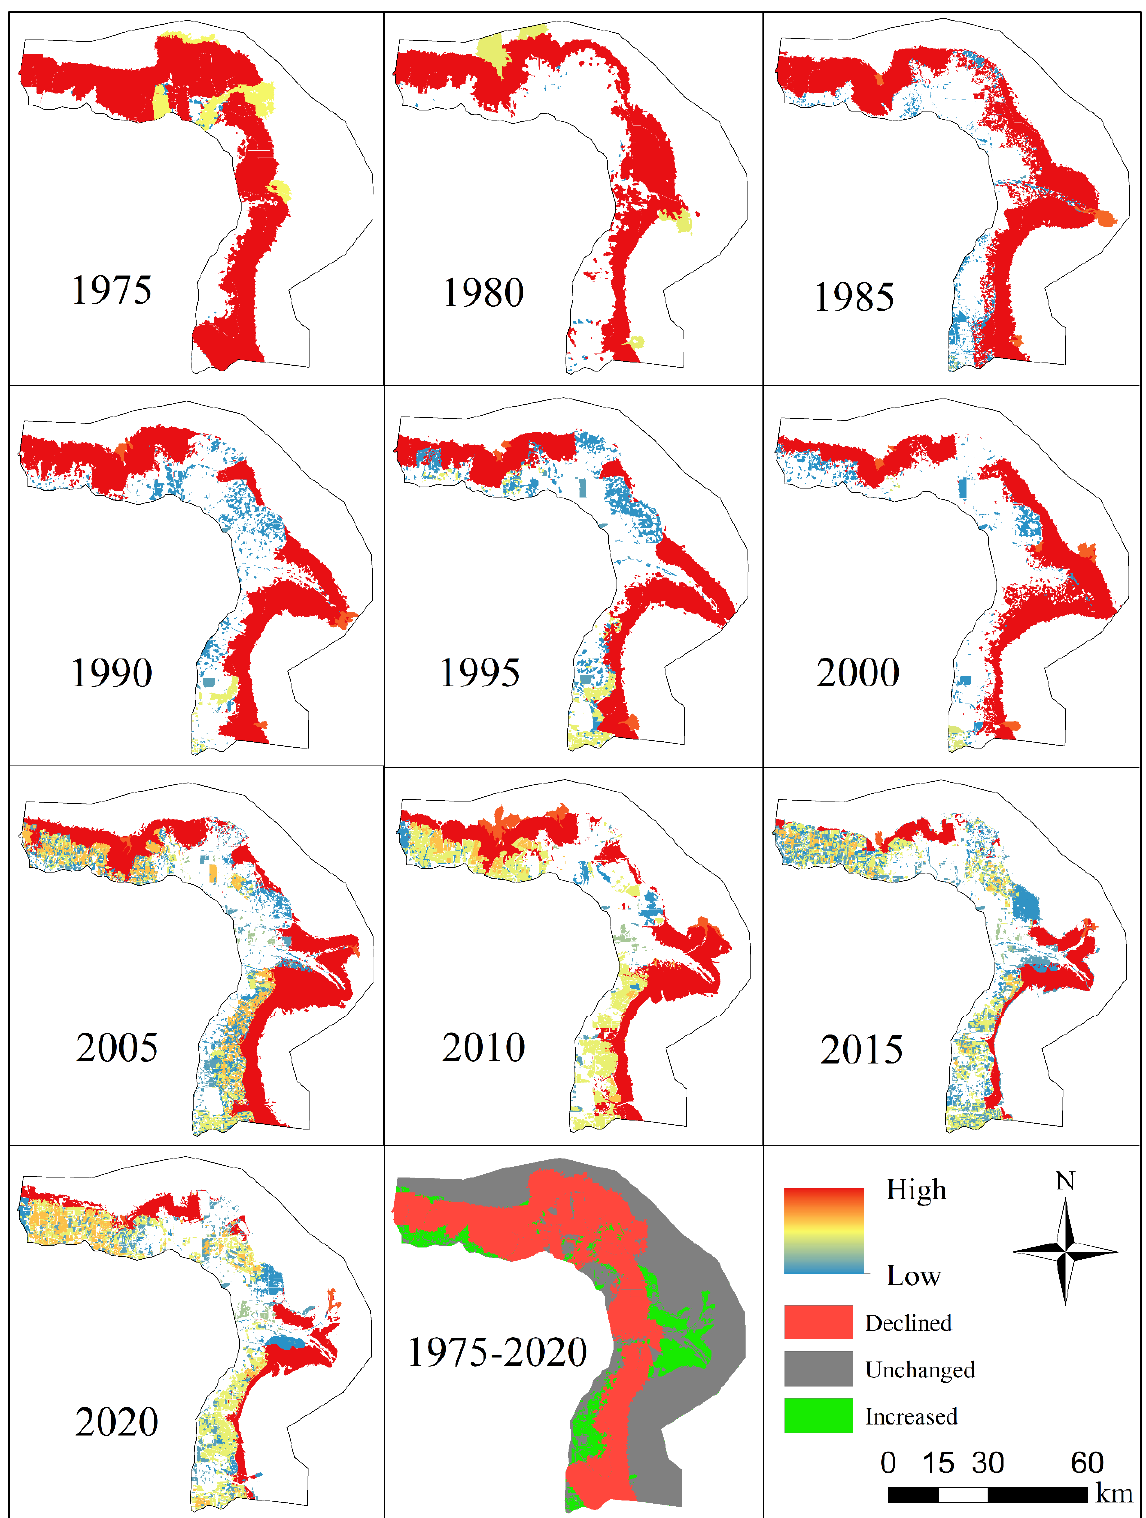
Figure 3. InVEST habitat quality model of the Yellow River Delta between 1975 and 2020. Medium ‐ and low ‐ quality habitat (MH) and high ‐ quality habitat (HH) accounted for 0.3% and 42.1% of all habitat in 1975 and 16.0% and 14.5% of all habitat in 2020, respec ‐ tively. A total of 53.0% of HH and 60.3% of MH were converted to non ‐ habitat (NH), and 21.5% of HH was converted to MH. In contrast, only 9.0% of NH improved to HH and 9.4% to MH (Figure 4). The transfer matrix of land use between 1975 and 2020 showed that habitat loss and degradation (e.g., HH to NH, MH to NH) were mainly caused by the occupation of construction sites and the degradation of artificial wetlands. Among the area of HH that was converted to NH, 13.4% was converted to industrial mining areas. Among the area of HH that was converted to MH, 52.3% was converted to mariculture